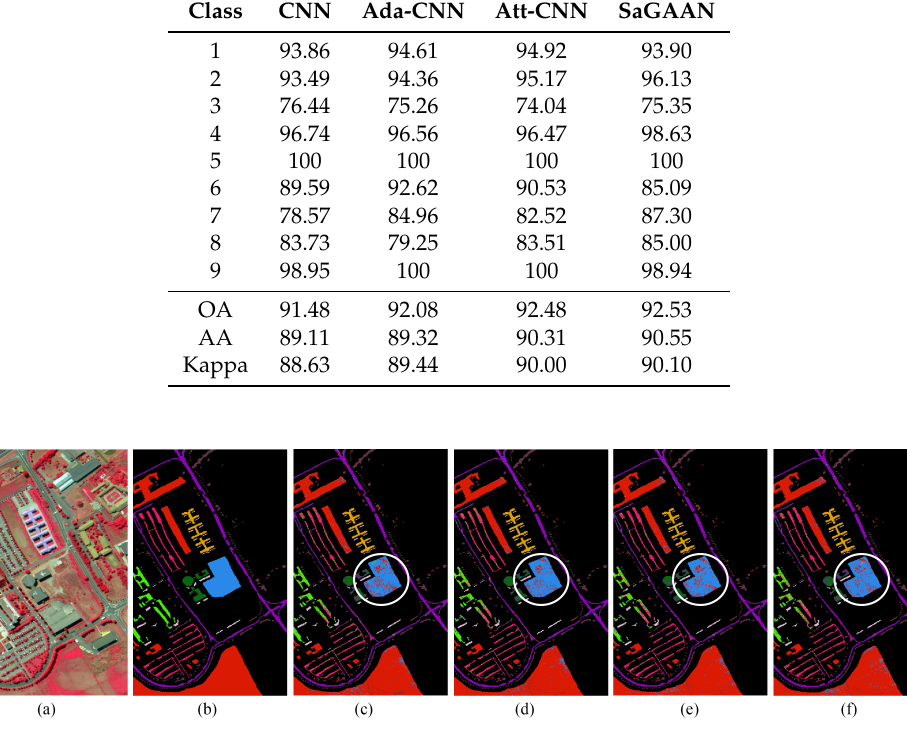
Figure 5. The classification maps of Pavia University dataset: ( a ) the original dataset; ( b ) the ground truth labels; ( c ) classification map with the original dataset; ( d ) classification map with domain adaptation term; ( e ) classification map with self-attention mechanism; and ( f ) classification map with